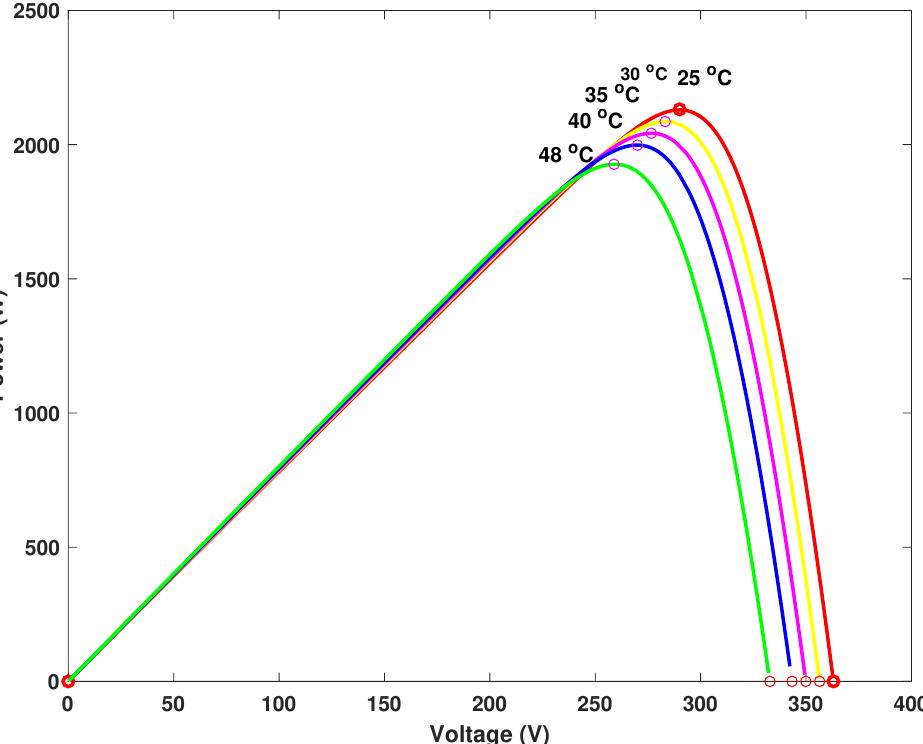
Figure 2. Characteristic curve of PV voltage and power under changing temperature.